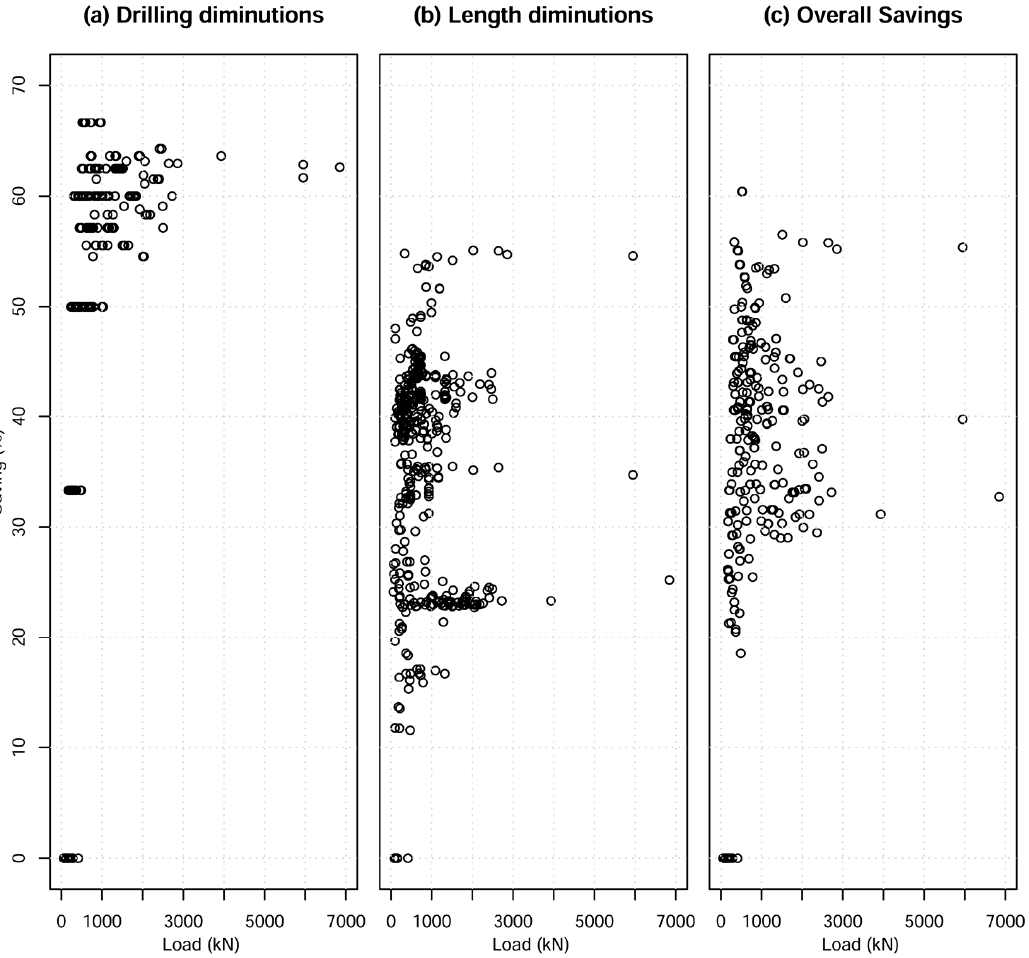
Figure 3. ( a ) Diminution of the number of drilling events per footing according to the service load. ( b ) Diminution of the overall length of micropiles per footing (isolated, strip or slab) according to the service load. ( c ) Savings on the cost per footing depending on the service load.